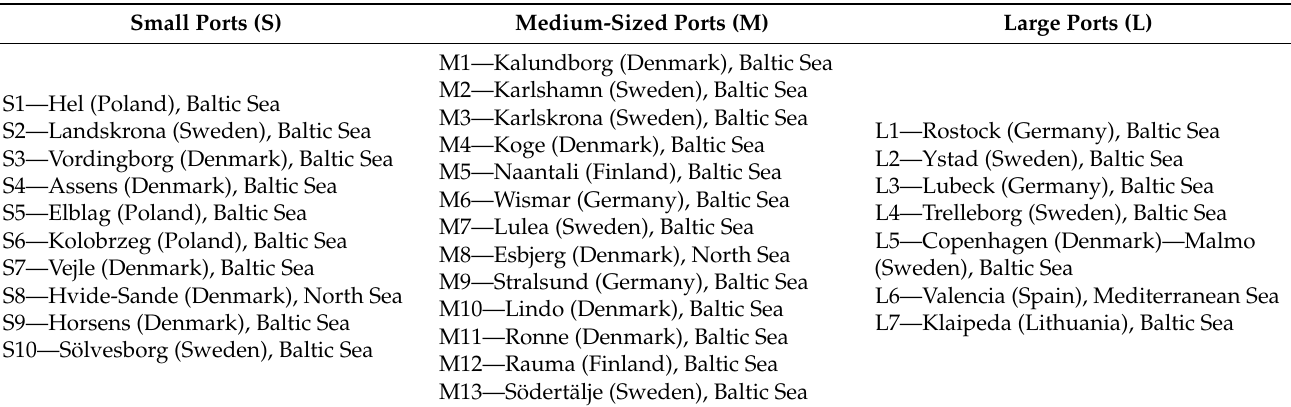
Table 2. List of seaports analysed in the case study.